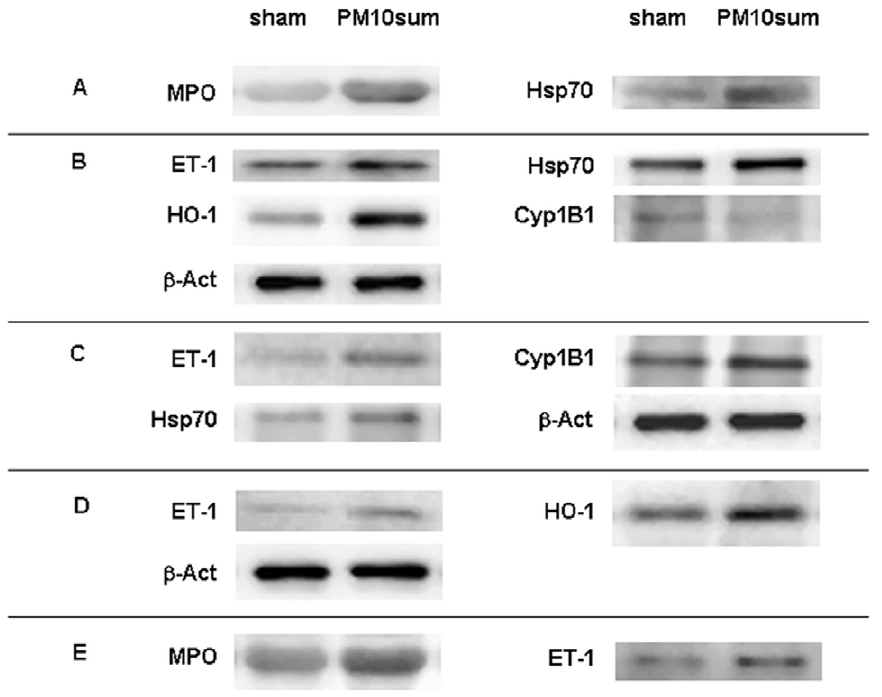
Figure 1. BALf, lung, heart, brain and plasma immunoblotings. Western blottings displaying proteins in BALf (A), lung (B), heart (C), brain (D) and plasma (E) in sham and PM10sum-treated mice, 24 h after the third intratracheal instillation. Reported blots are representative of 6 sham and 6 PM10sum-treated mice; densitometry analyses are reported in Tab.1.